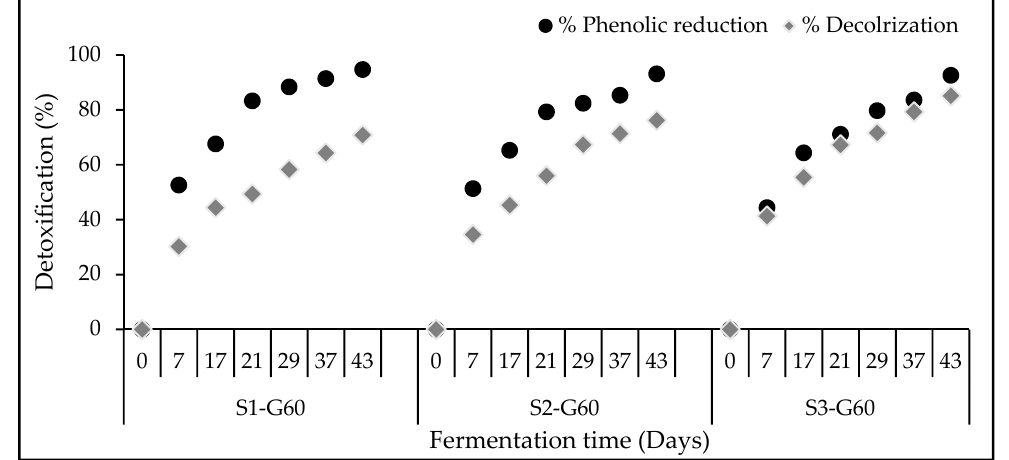
Figure 3. Kinetics of % phenol reduction and % decolorization of the medium during cultivation of P. pulmonarius in liquid cultures with OMWs containing 1, 2 and 3 g/L phenolic compounds and initial concertation glucose ( a ) 40 g/L (S1-G40, S2-G40, S3-G40) and ( b ) 60 g/L (S1-G60, S2-G60, S3-G60, see Table 2). Each point is the mean value of at least three independent measurements, SD < 5%.